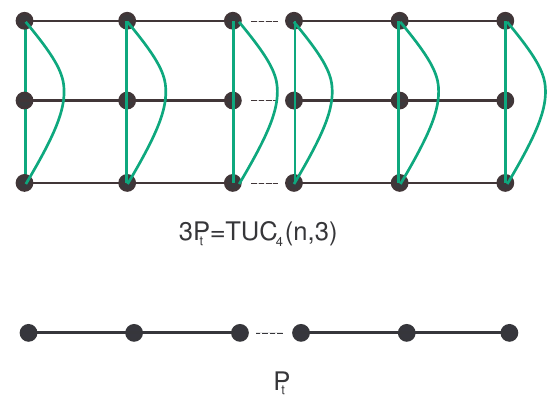
Figure 3. 3 P t as carbon nanotube TUC 4 ( n ,3 )